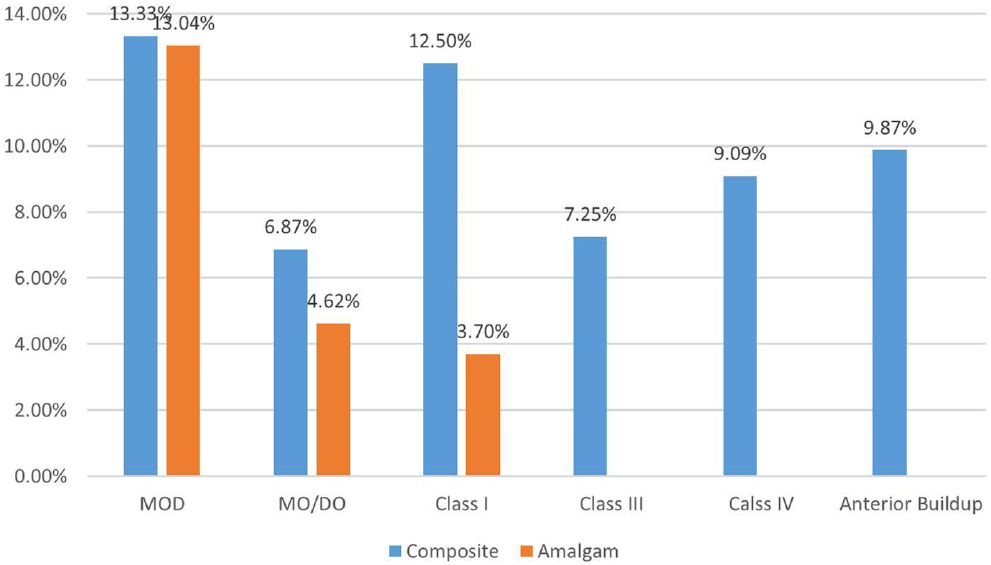
Figure 1. Comparison of failure rates of amalgam and composite restorations. Each bar shows the failure rate (ratio of failure/total treated teeth × 100) of that kind of restoration. The overall failure rate of amalgam restorations was 5.33% (9 out of 169) and for posterior composite restorations it was 9.96% (26 out of 261). No amalgam filling was done in Class III, IV, and anterior buildup.